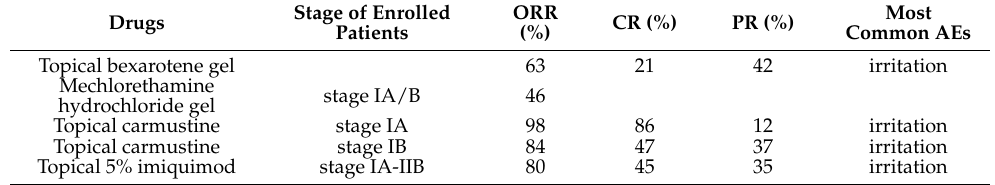
Table 1. The efficacy of topical formulations for treatment of anti-cutaneous T cell lymphoma.